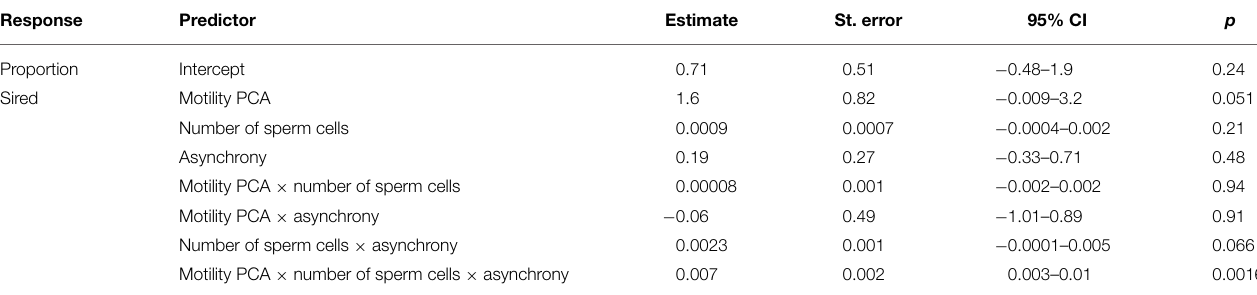
TABLE 1 | Parameter estimates (SE, 95% CI and p -values) for the effects of sperm velocity and motility in water and ovarian fluid (i.e., motility PCA), sperm quantity (i.e., number of sperm cells), ejaculate release delay (i.e., asynchrony) and the interactions on proportion of larvae sired ( n = 128 ).